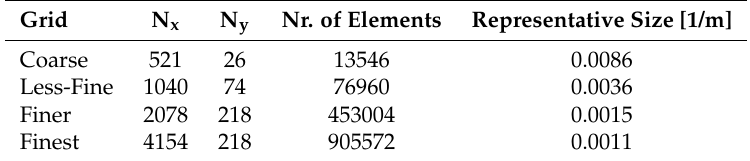
Table 2. Mesh properties for the four different meshes used in the study. Representative size is defined in Equation (9). Grid N x N y Nr. of Elements